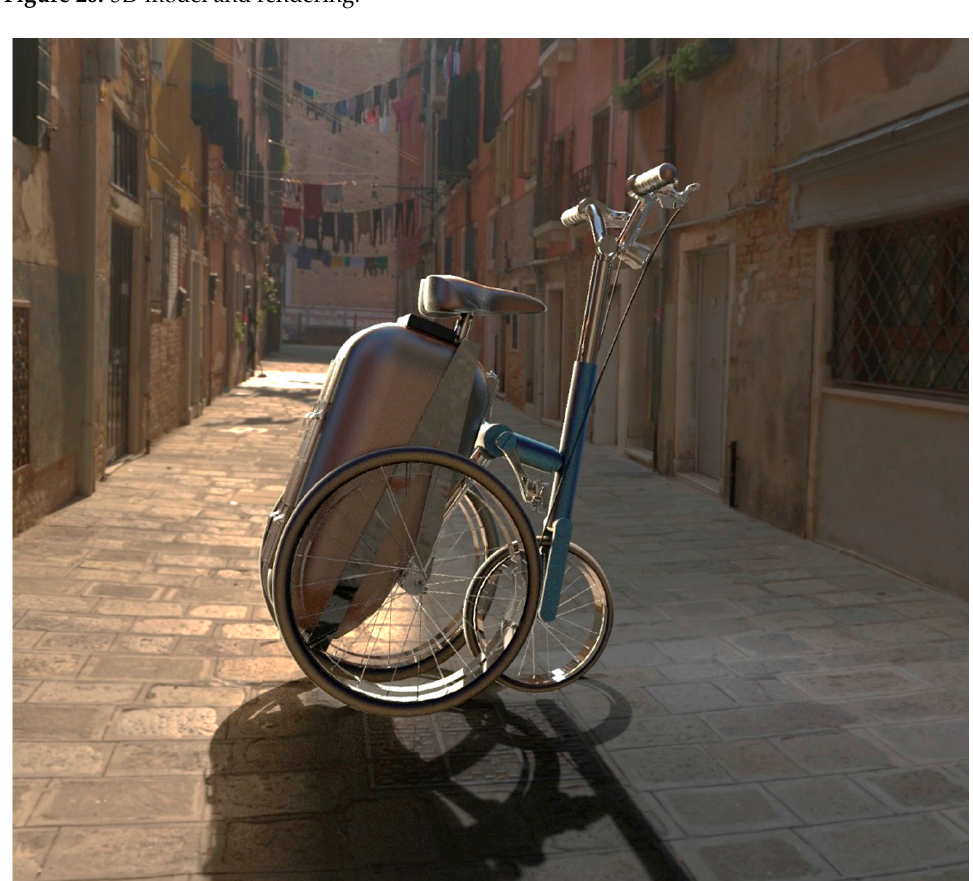
Figure 21. 3D model and rendering.